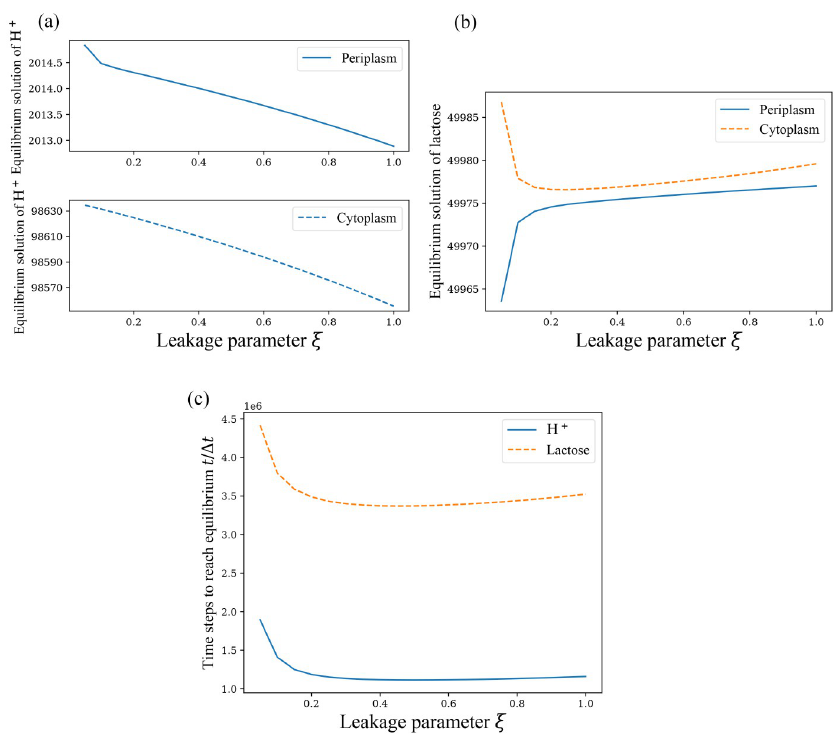
Fig 3. Equilibrium properties of lactose permease symport in E . coli when ξ = η . Only the ξ 6¼ 0 cases are shown with the initial conditions the same as Fig 2. The vertical coordinate represents the number of particles in (a) and (b). (a) The equilibium solution of H + in periplasm and cytoplasm. (b) The equilibium solution of lactose in periplasm and cytoplasm. (c) Time used to reach equilbrium state for H + and lactose with the unit of Δ t .